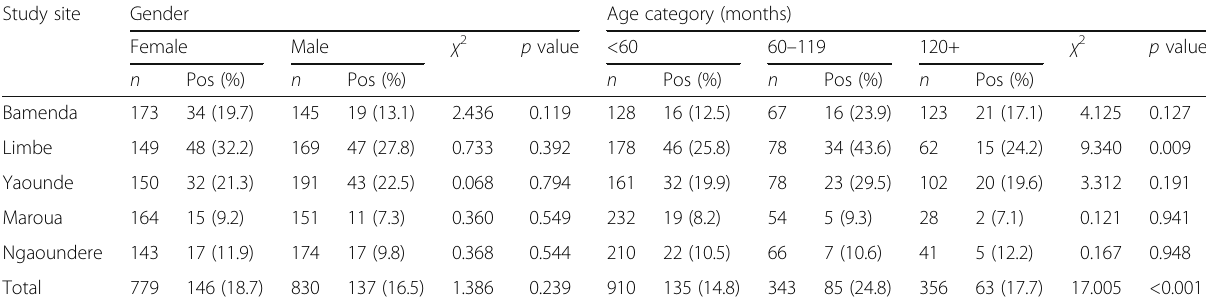
Table 3 Distribution of malaria in the study population stratified according to age, gender and study site Study